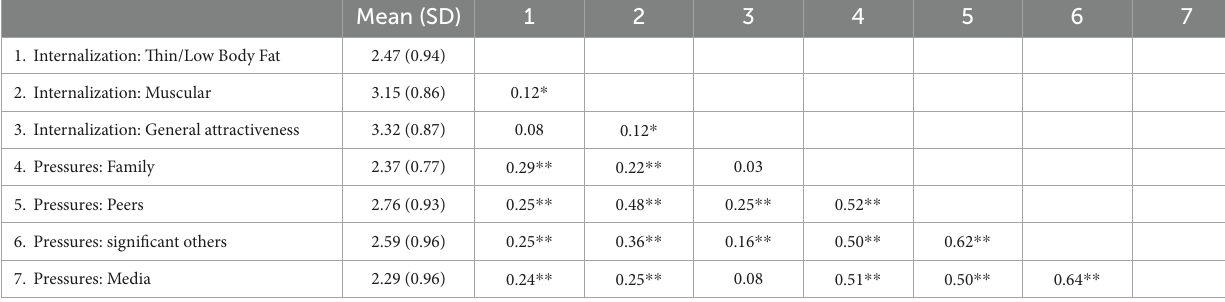
TABLE 4 Correlations between the Chinese SATAQ-4R subscales and convergent measures. (Female: N = 344; Male: N = 335).